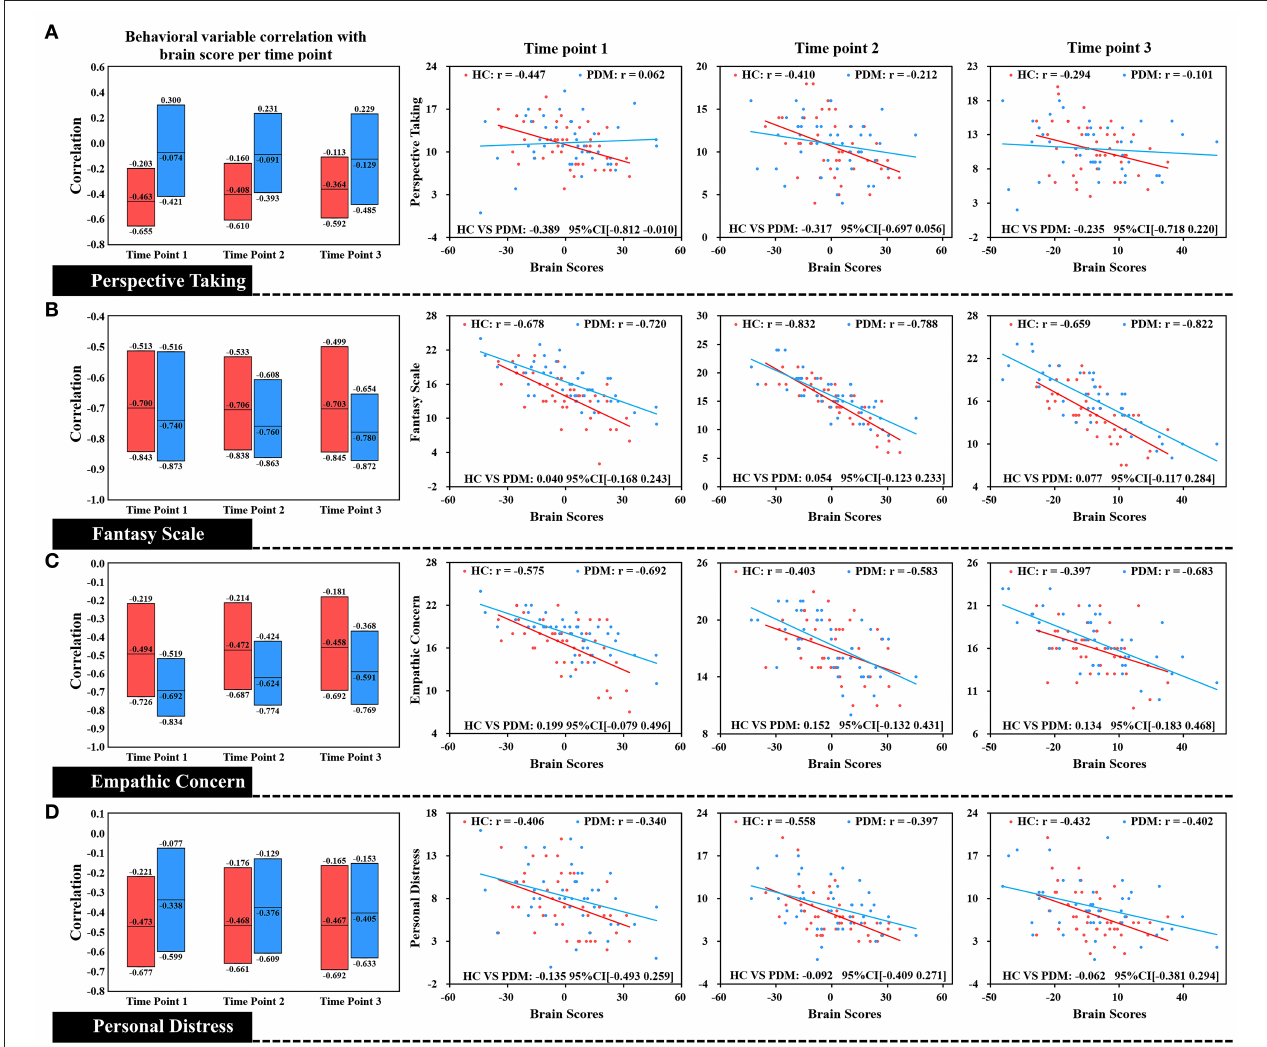
FIGURE 4 | Correlation of each level of trait empathy with brain scores of LV 2. In the box plot, the middle line of the box is the original correlation between empathy and brain score in the same phase. The boundary of the box was the 95% CI of the trait empathy correlation with brain scores based on the use of 5,000 bootstraps. The original correlation between empathy and brain score is shown by the scatter plot. There were no significant differences between HC and PDM in the EC, FS, and PD correlations with brain scores at the periovulatory, luteal, and menstruation phases based on effect-size analysis. The correlations in both groups did not significantly change during the three